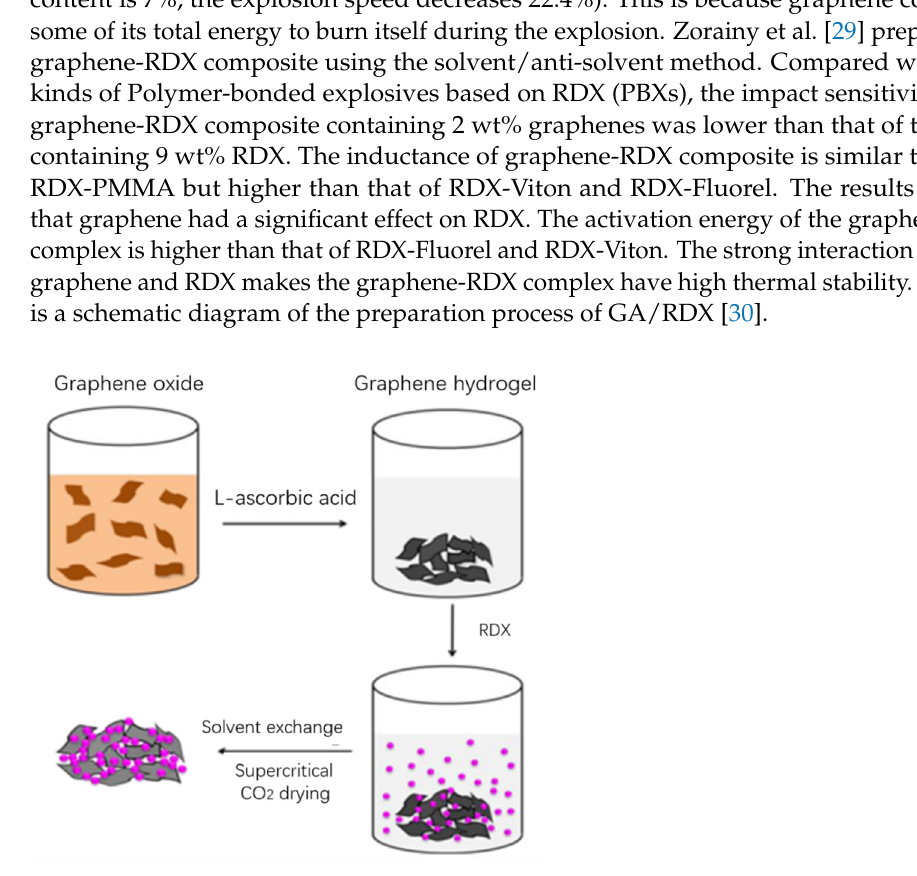
Figure 9. Schematic diagram of the preparation of GA/RDX nanocomposites [30]. permission from ref. [30]. Copyright 2016 Springer